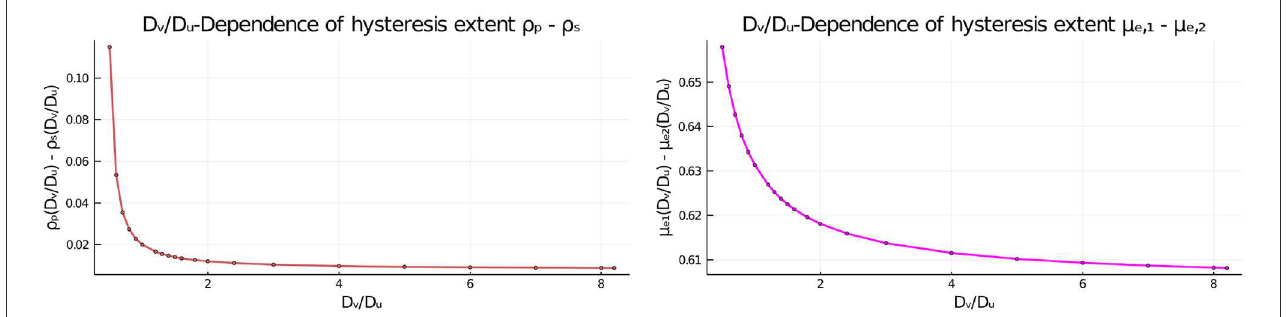
0.08, as measured by the distance between the fold =